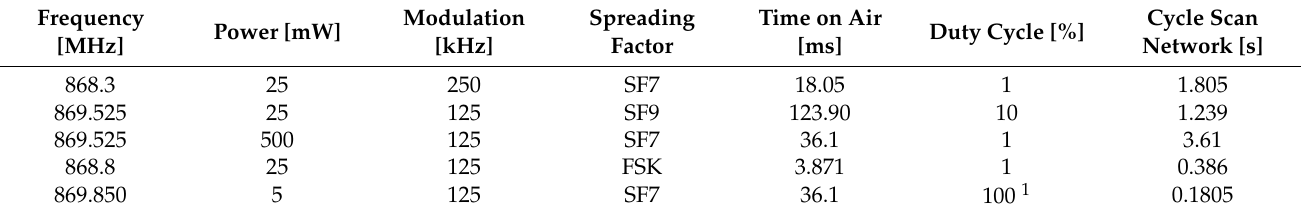
Table 3. Network configuration vs. duty cycle, time on air and data transmission period with 6 bytes of data transmission.